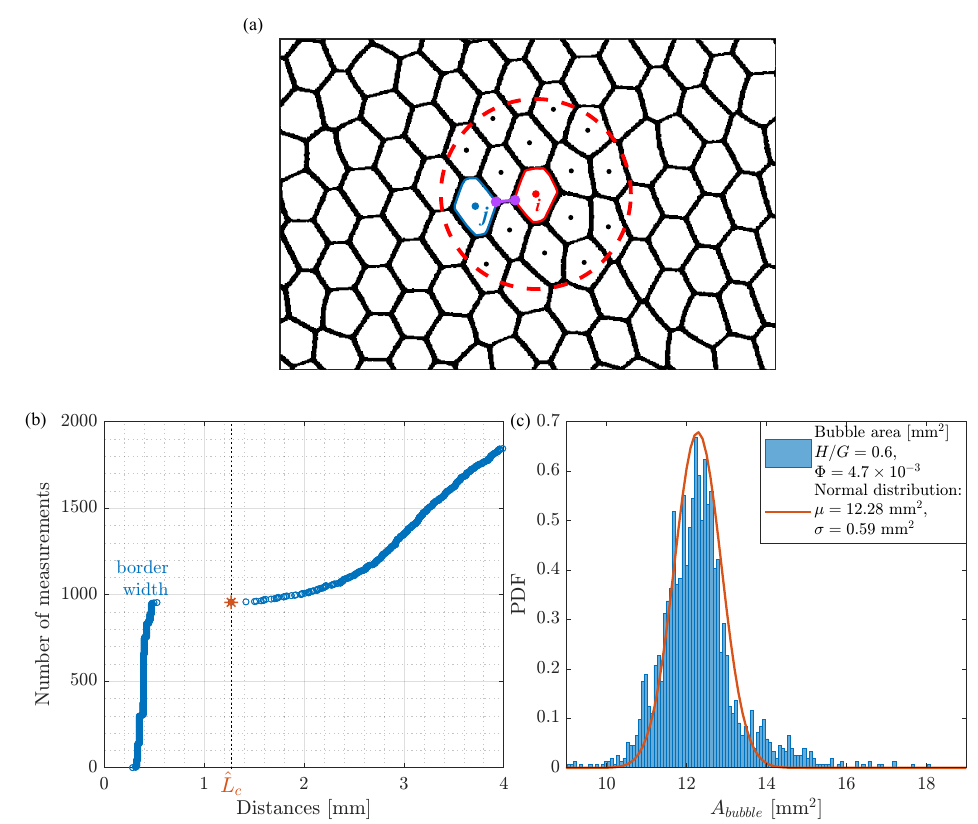
Figure 2. Method used to find the critical distance L c before rearrangement (or T1 event) occurs: ( a ) selection of a bubble and all its neighbors, which are located at a distance less than 2 d mean from its center; ( b ) an example of sorted distances between the foam cells in the ascending order, the red star indicates ˆ L c —the critical distance plus border width; ( c ) histogram of bubble areas superposed with a Gaussian fit (Normal distribution with s = 12.28 mm 2 and σ = 0.59 mm 2